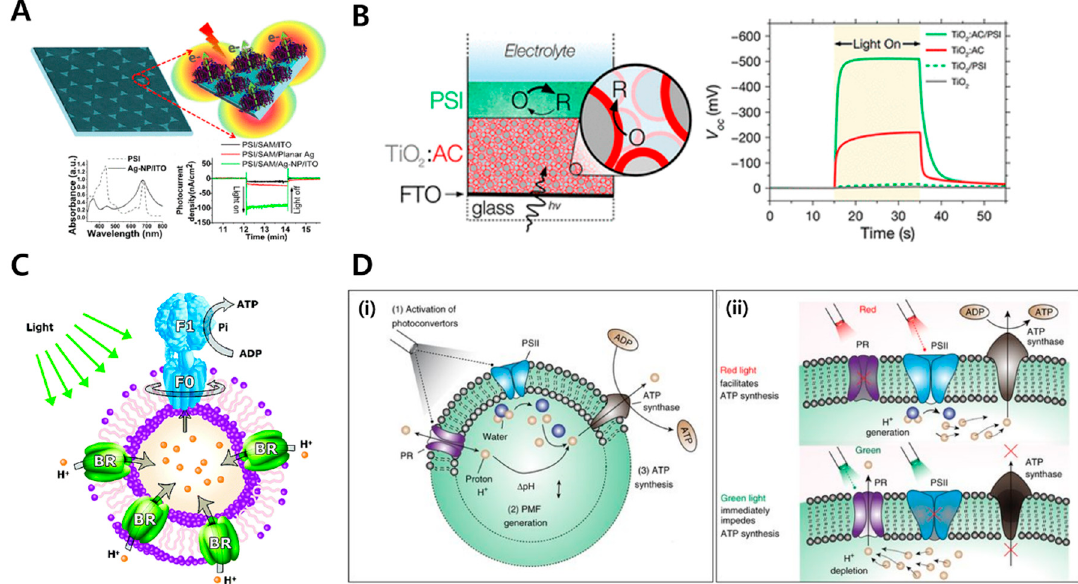
Figure 9. Energy harvesting application of transmembrane proteins. ( A ) Plasmon-enhanced photocurrent from photosystem I assembled on Ag nanopyramids [17]. With this system, the plasmon-enhanced photocurrents were enhanced up to ~6.5 and ~5.8 compared to PSI assembly on planar Ag substrates for wavelengths of 660 and 470 nm, respectively (Reproduced with permission from Pamu, R. et al. J. Phys. Chem. Lett. , 2018. Copyright 2018 American Chemical Society). ( B ) PSI multilayer film structure and increased photovoltage range [18]. A PSI multilayer film is assembled on a mesoporous film of TiO 2 nanoparticles. The PSI multilayer promotes a more than 2-fold increase in photovoltage (Reproduced with permission from Robinson, M. T. et al. ACS Appl. Energy Mater. , 2018. Copyright 2018 American Chemical Society.). ( C ) Schematic representation of the proteopolymersome reconstituted with both bR and F 0 F 1 -ATP synthase [19]. When light reaches the bR, the proton transfers from outside to inside the proteopolymersome. Then, the generated proton gradient promotes ATP synthesis by ATP synthase. As a result, ATP is synthesized outside the proteopolymersome (Reproduced with permission from Choi and Montemagno, Nano Lett. , 2005. Copyright 2005 American Chemical Society). ( D ) Design and applications of the artificial photosynthetic organelle [20]. Using PR and PSII, ATP synthesis is controlled by different wavelengths of light. Red light facilitates ATP synthesis, while green light impedes ATP synthesis (Reproduced with permission from Lee, K. Y. et al. Nat. Biotechnol. , 2018. Copyright 2018 Springer Nature.).